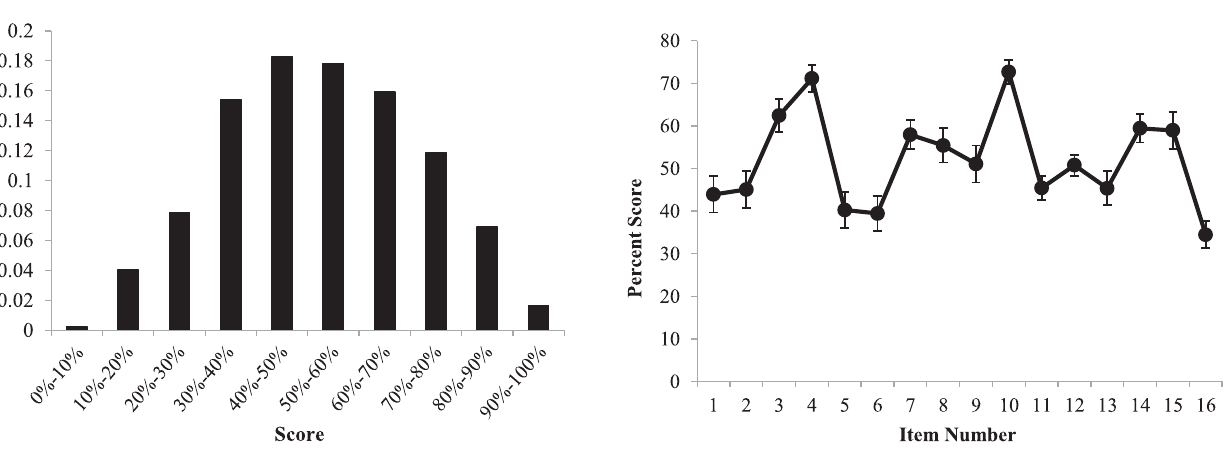
FIG. 2. Distributions of scores ( N ¼ 421 ) on the CMR CUE from 15 courses at the institutions described in Table I. These data did not pass a statistical test for normality (Anderson-Darling test, p ¼ 0 . 03 ).